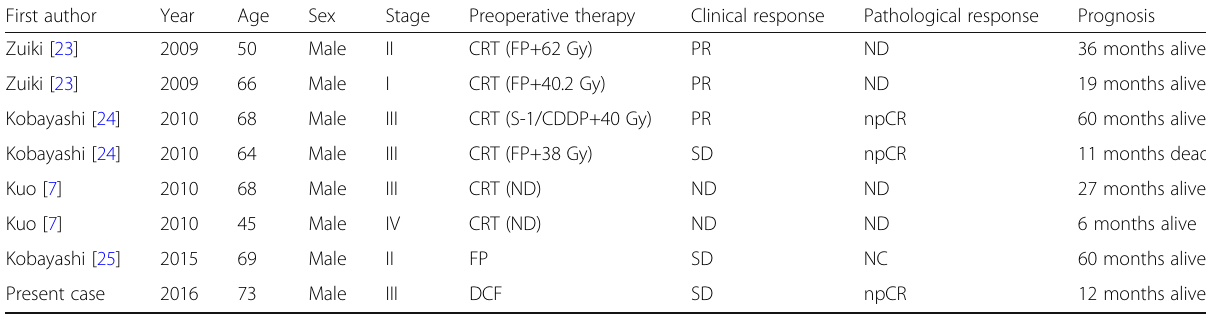
Table 1 Esophageal carcinosarcoma treated with preoperative therapy First